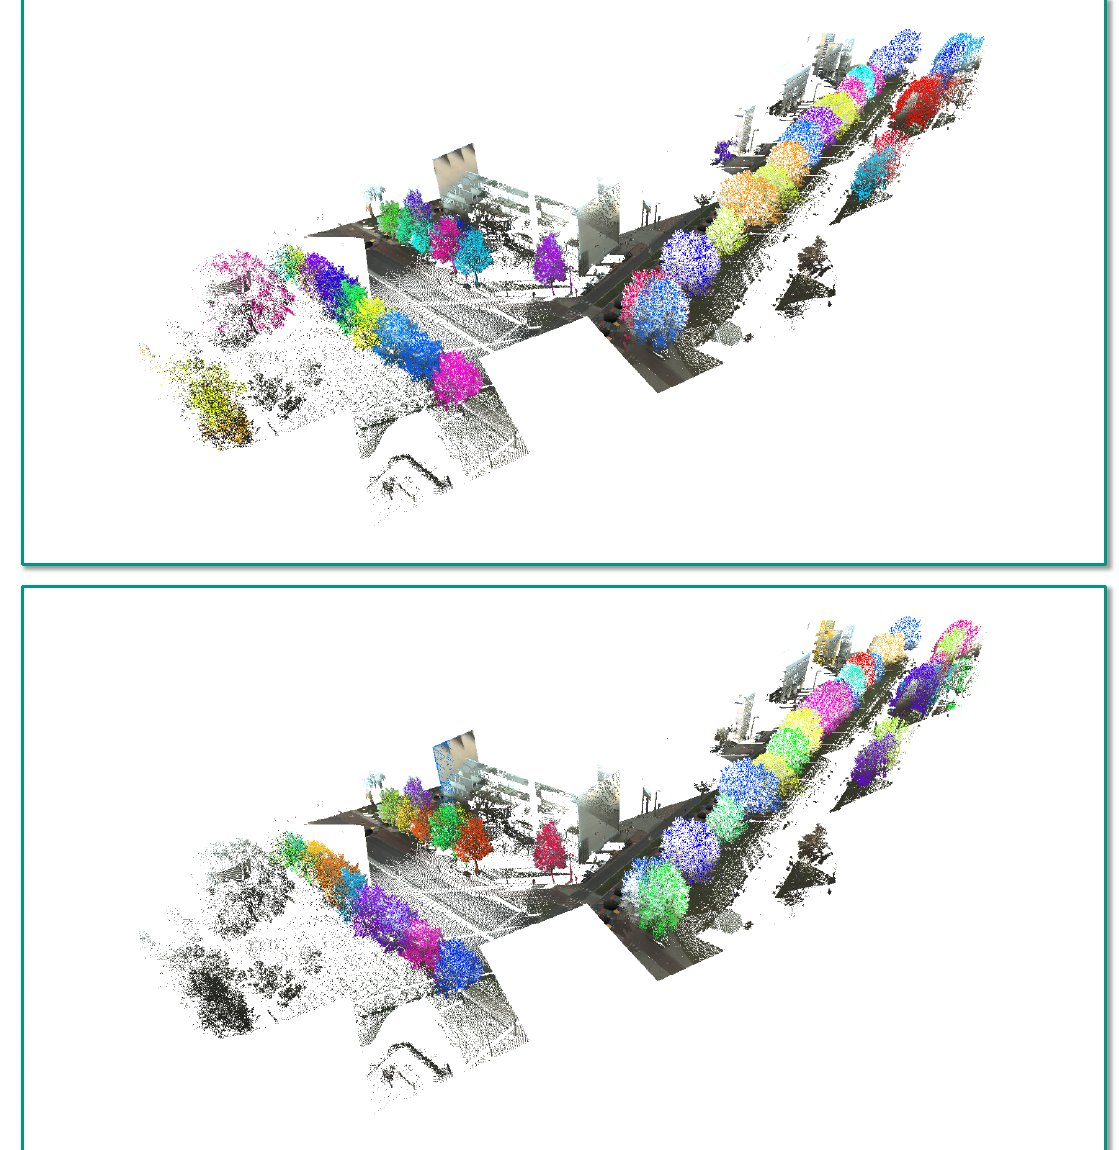
Figure 11. Visualization of the individual trees detected in the considered scene when relying on a classification based on the feature set S 3D+2D ( top ) and when relying on a classification based on the feature set S FCBF ( bottom